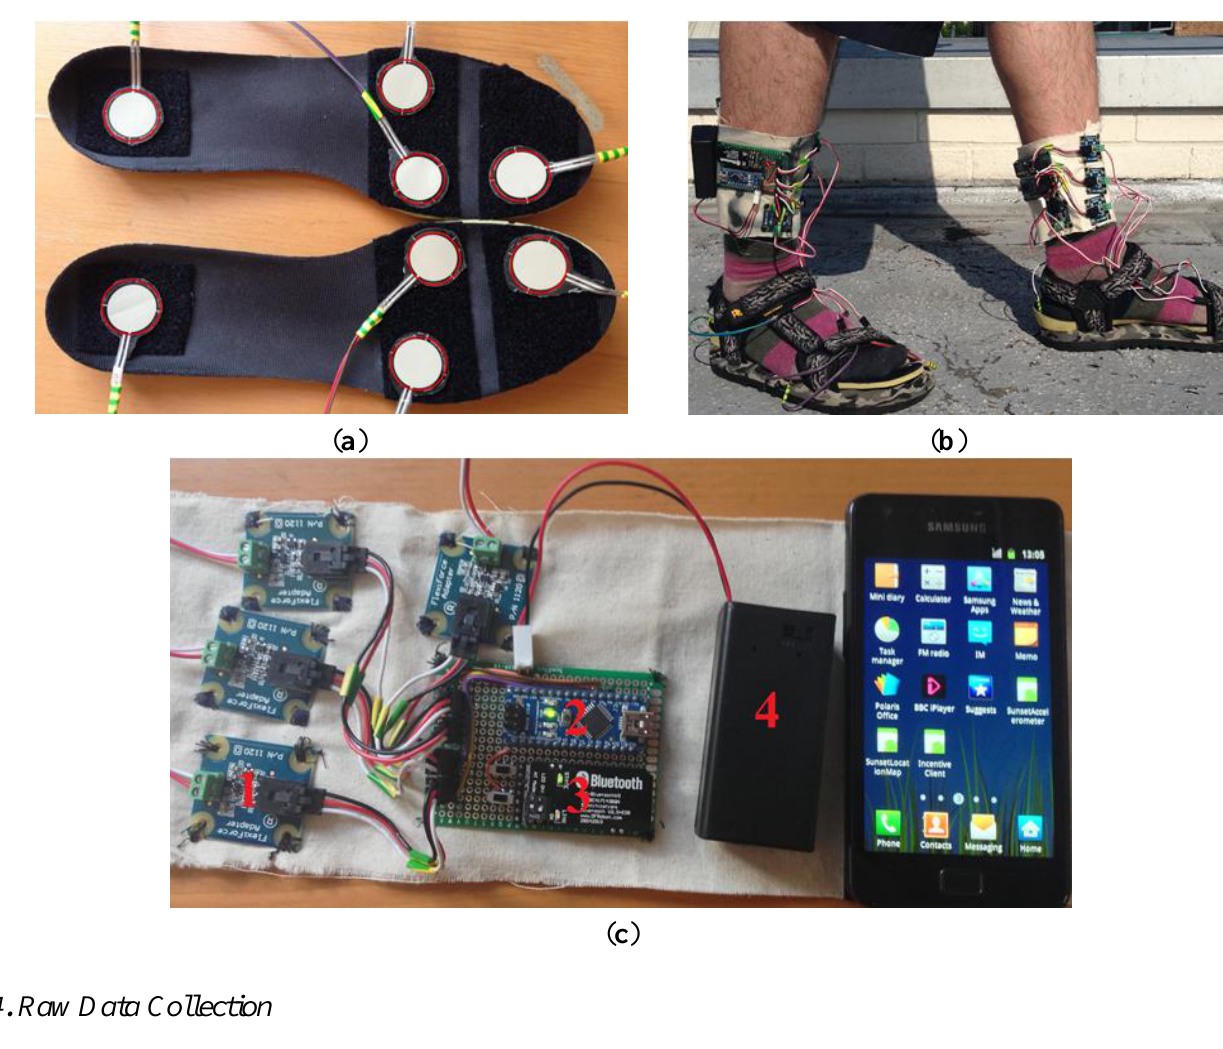
Figure 2. Experiment equipment: ( a ) two insoles with 8 Flexiforce sensors instrumented; ( b ) the wearable sensor prototype; ( c ) The foot force sensing system and a Samsung galaxy II smart